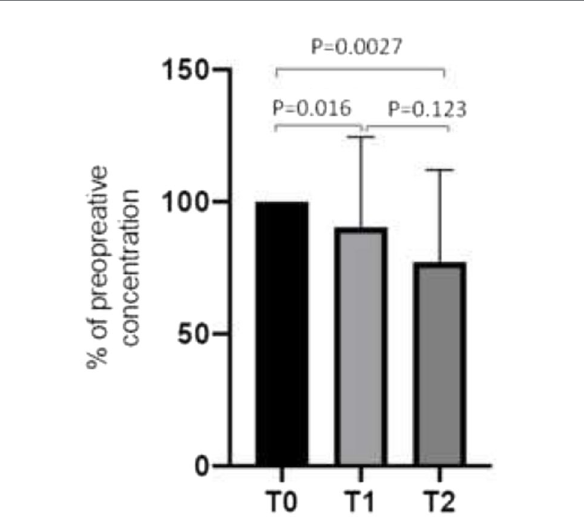
FIGURE 2 Plasma concentration of antidepressants SSRI/SNRI in patients undergoing bariatric surgery ( n = 46): before (T0), 1 month (T1), and 6 months (T2) after bariatric surgery. To compare the plasma concentrations of the different SSRI/SNRI preoperative levels are set to 100%, and the values on T1 and T2 ( μ g/L, pmol/L, and mmol/L, respectively) are converted to %. Data are mean ± SD.